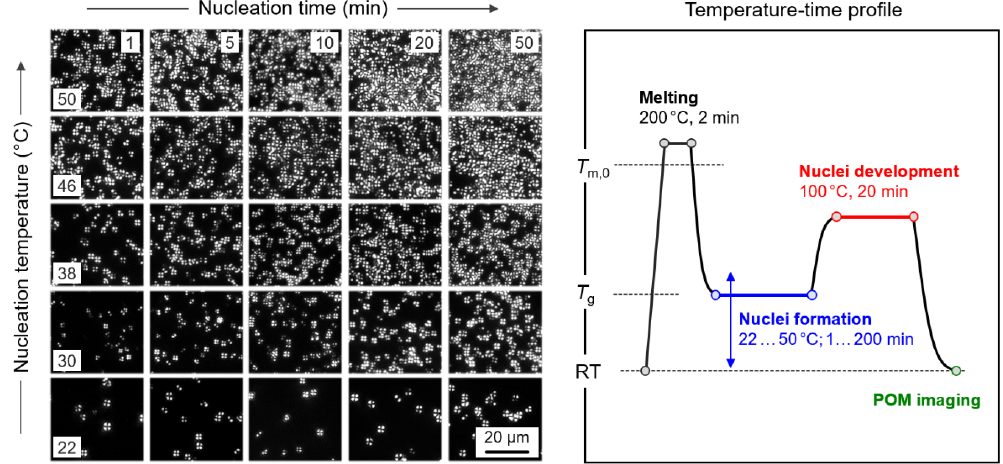
Figure 2. Temperature–time profile for optical analysis of isothermal nuclei formation in PBI, using Tammann’s two-stage crystal nuclei development method (right). The left part of Figure 2 shows selected polarized-light optical microscopy (POM) micrographs of PBI crystallized at 100 °C for 20 min, after nuclei formation at temperatures between 22 °C (bottom row) and 50 °C (top row) for annealing times between 1 min (left column) and 50 min (right column).